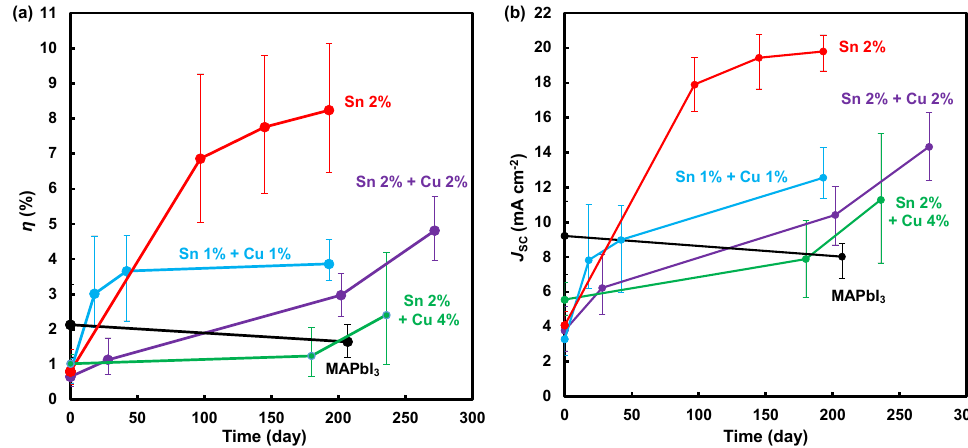
Figure 3. Changes of ( a ) photoelectric conversion efficiencies, and ( b ) short-circuit current densities.